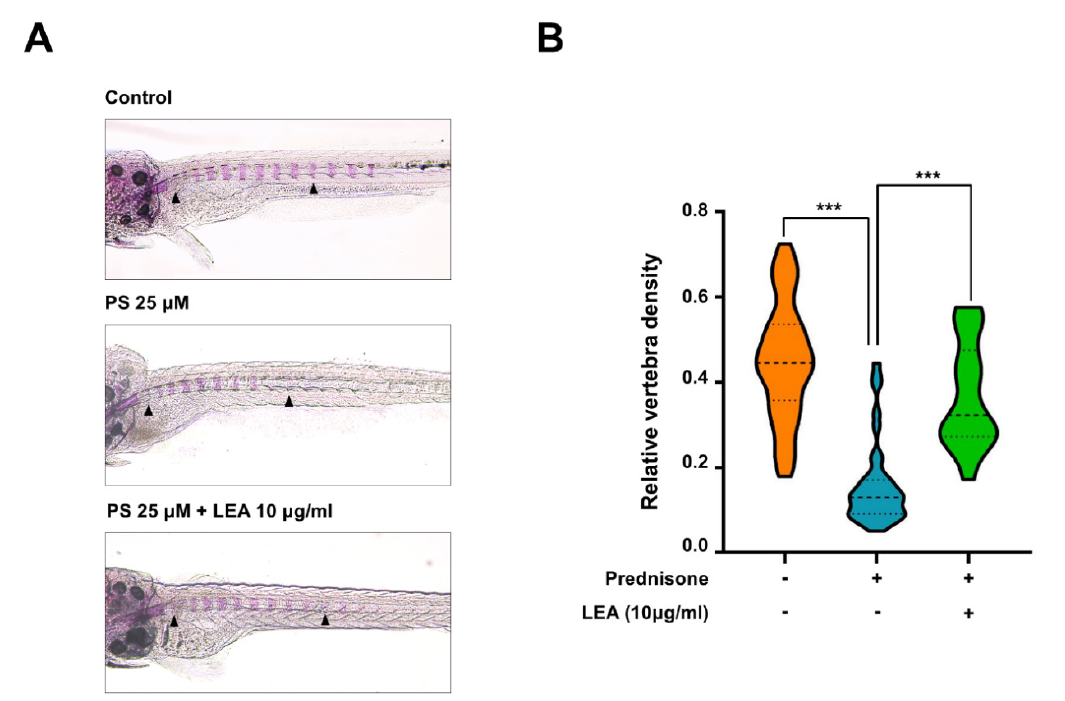
Figure 5. Anti-osteoporotic e ff ect of LEA in a model of prednisolone-induced osteoporosis in zebrafish. ( A ) The larvae at 10 dpf (days post-fertilization) were treated with 25 µ M prednisolone (PS) in the presence or absence of LEA (10 µ g / mL) for 3 days. Whole-mount Alizarin red staining was performed to analyze the mineralized bone. Arrowheads indicate the bone Alizarin red staining. ( B ) Relative vertebral bone density was assessed by measuring the areas of the first ten stained vertebrae (V1–V10, indicated by arrowhead in (A)). *** p < 0.001 versus only prednisolone treatment.